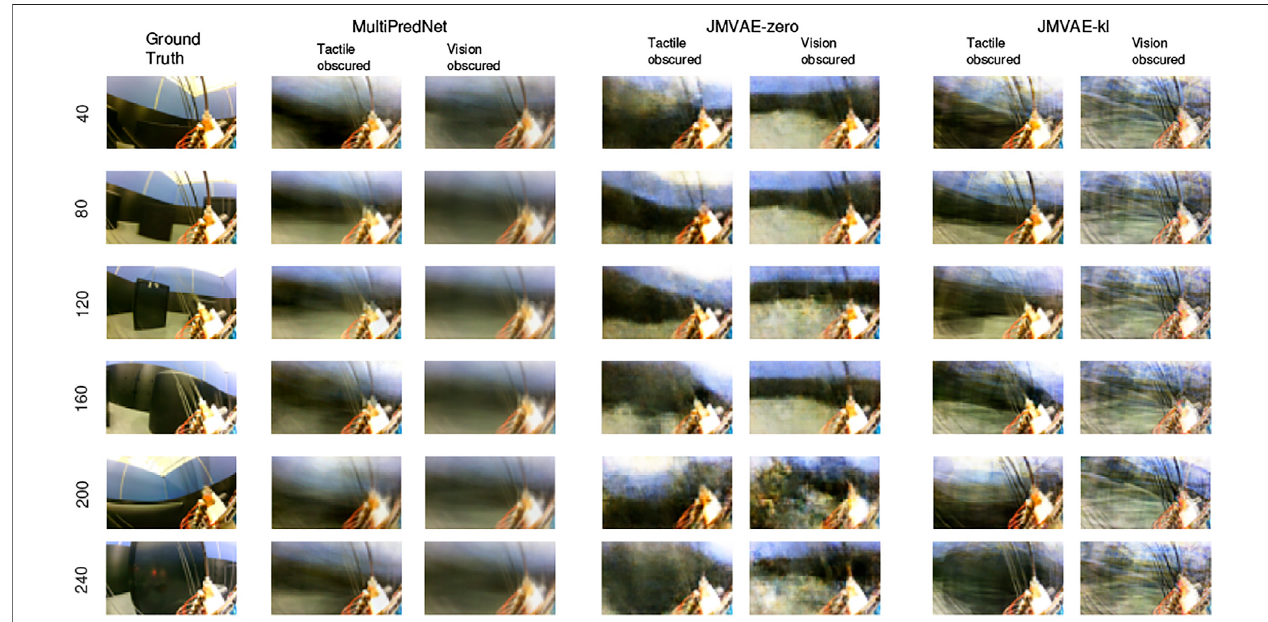
FIGURE 12 | Example frames captured by the eye camera that are presented as visual input to the trained models with their subsequent reconstructions in the 2 sensory drop-out conditions. The Ground truth images in the left column were taken at the sample number indicated to the left of each panel with each reconstruction from themodelspresentedinthatrow.Thereconstructions arequalitatively similar intheirquality acrossall3models, however,MultiPredNetdid returnthelowest mean squared reconstruction errors in all conditions as shown in Figure 8 .